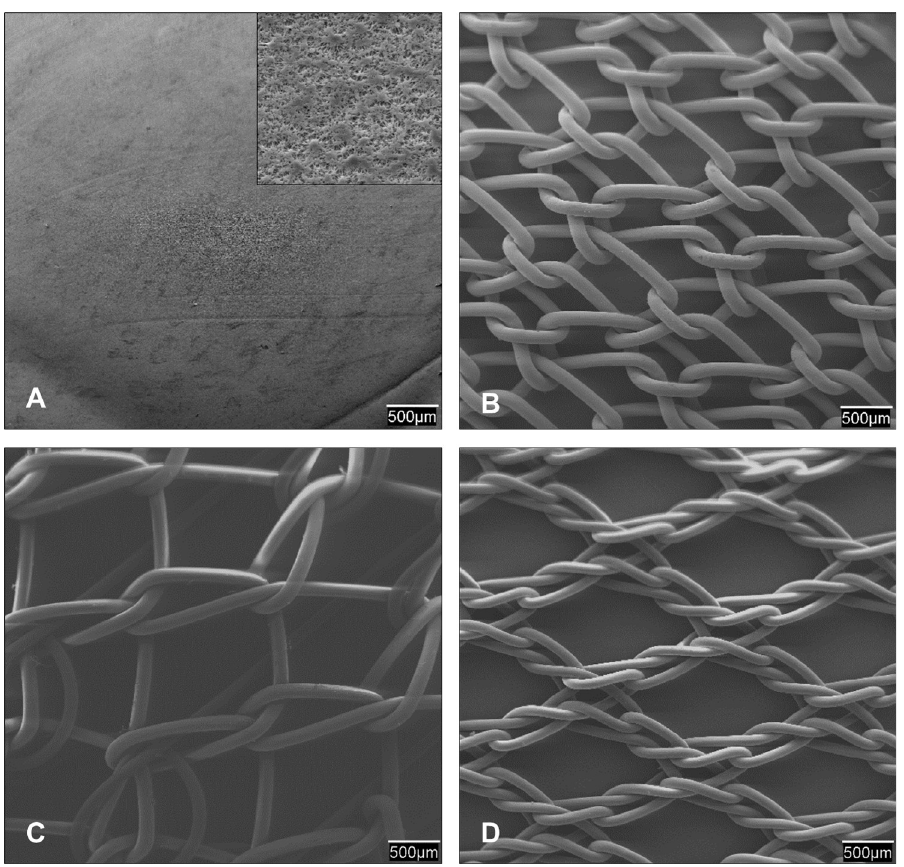
Fig 1. Characterization of the prosthetic materials. Scanning electron microscopy (SEM) images (20x magnification) of: (A) the laminar expanded polytetrafluoroethylene (ePTFE). A further magnified view (2000x) is shown in the box; (B) The bare reticular polypropylene alone (PP, Surgipro); (C) DynaMesh (PP interwoven with polyvinylidene fluoride, PVDF) and (D) TiMESH (PP coated with titanium). Note that for DynaMesh (C) the PVDF side (designed to be viscerally deployed) is